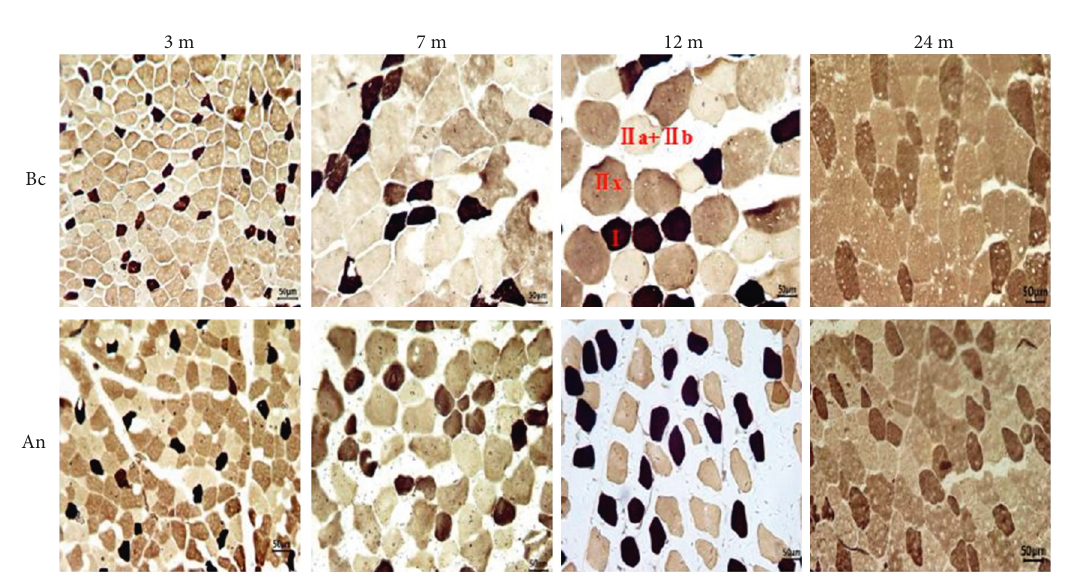
Figure 1: The longissimus dorsi muscle ATPase staining of Xinjiang brown cattle and Angus cattle ( ×